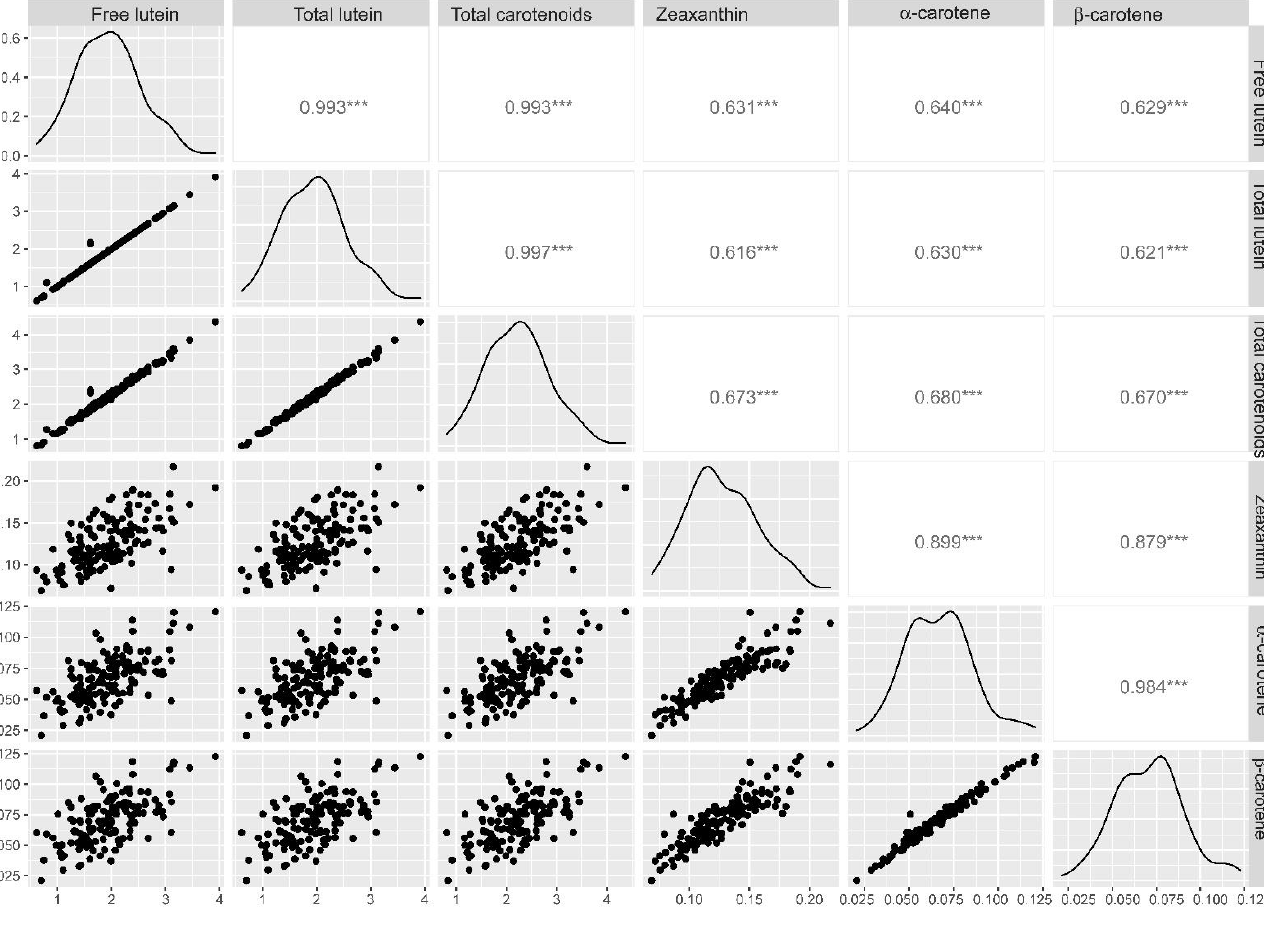
Figure 3. Pearson correlations and density functions showing the distribution of traits (mean values of both seasons). *** p < 0.001.